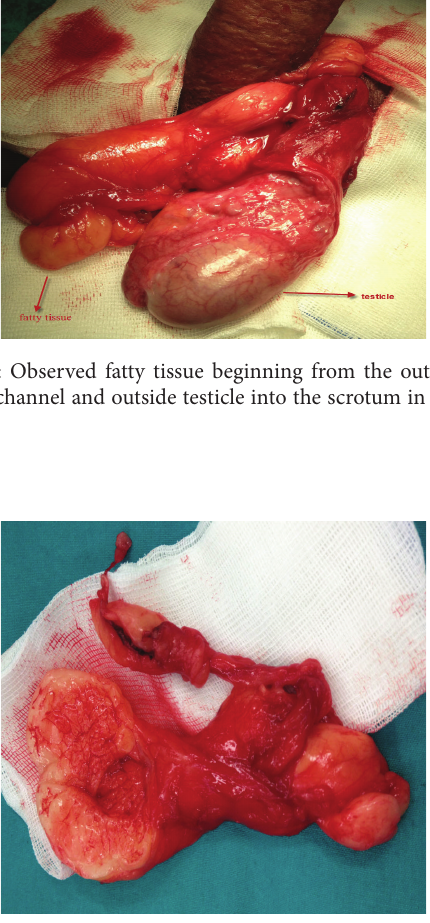
of in the differential diagnosis of swelling within the